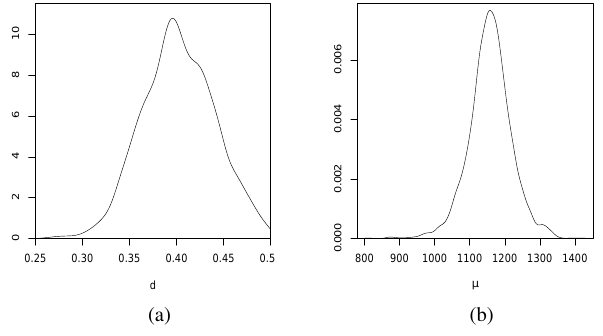
Figure 11. Marginal posterior densities for Nile minima; (a) d , (b) µ